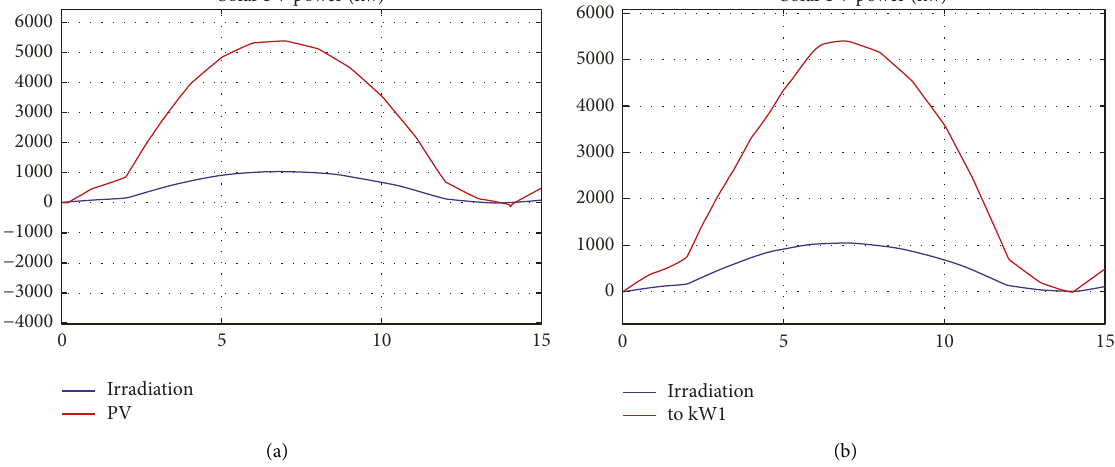
Figure 21: Output power for (a) ANN (b)